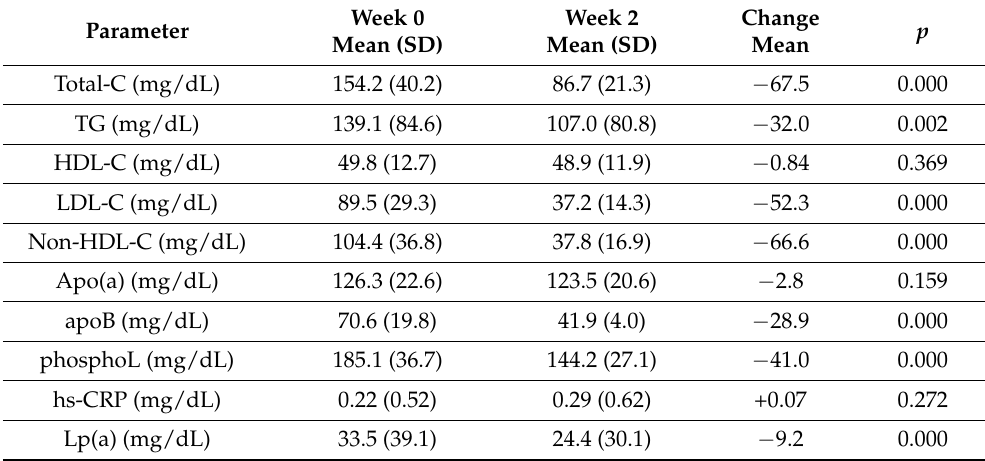
Table 2. Changes in blood tests from the baseline to 2 weeks after evolocumab